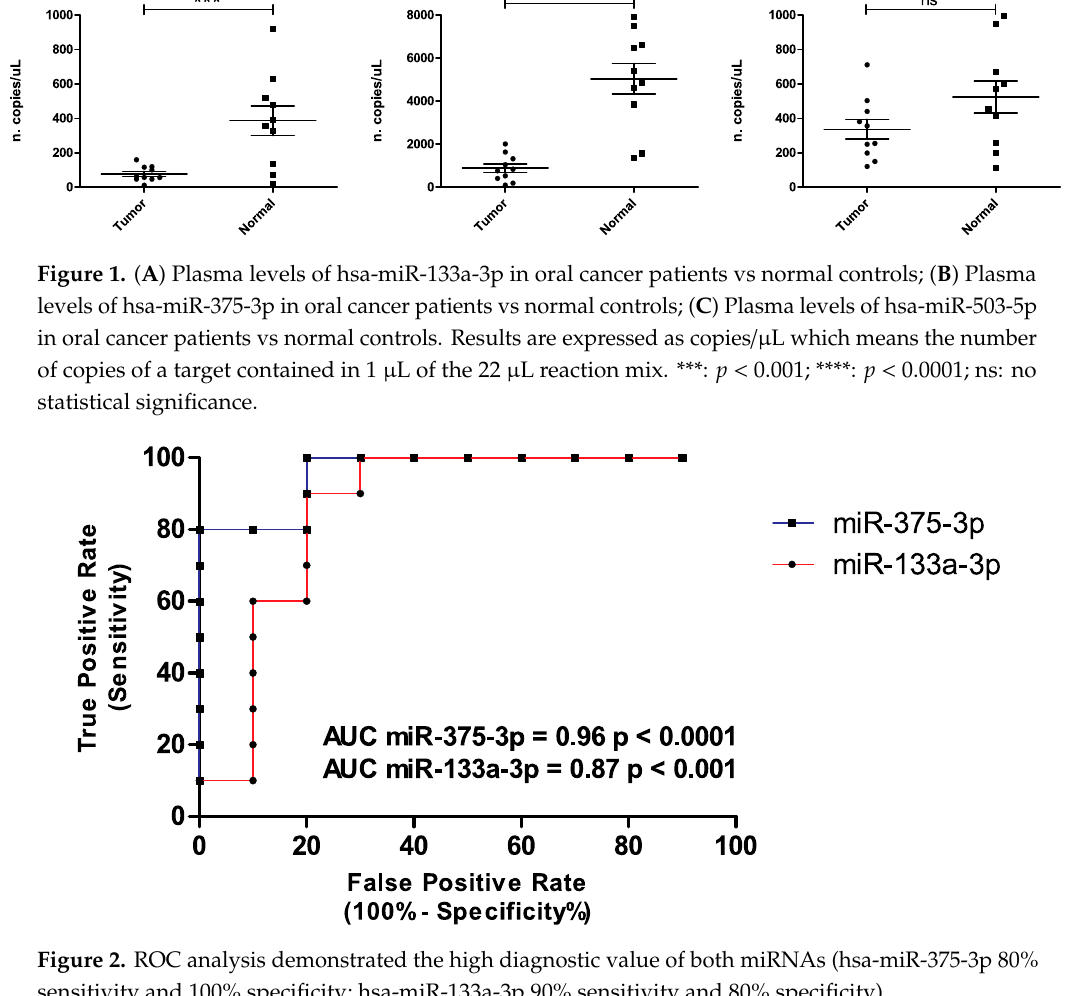
Figure 2. ROC analysis demonstrated the high diagnostic value of both miRNAs (hsa-miR-375-3p 80% sensitivity and 100% specificity; hsa-miR-133a-3p 90% sensitivity and 80% sensitivity and 100% specificity; hsa-miR-133a-3p 90% sensitivity and 80% specificity).